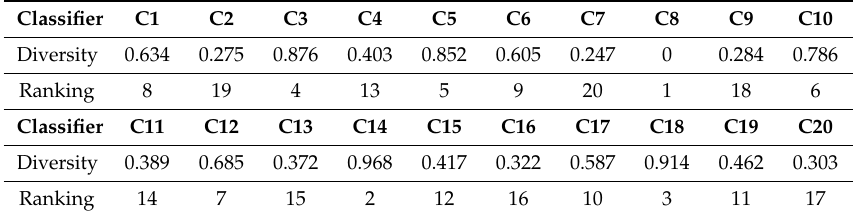
Table 7. Diversity values for base classifiers in the multiclassifier